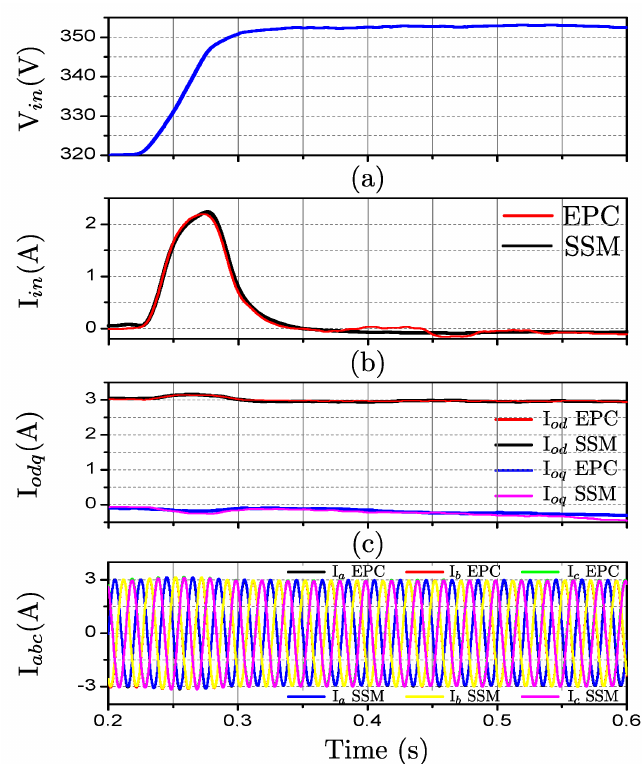
Figure 9. Comparison between ( a ) I in , ( b ) I odq and ( c ) I abc of the EPC and the small-signal model (SSM) for a step in V in of 30 V.